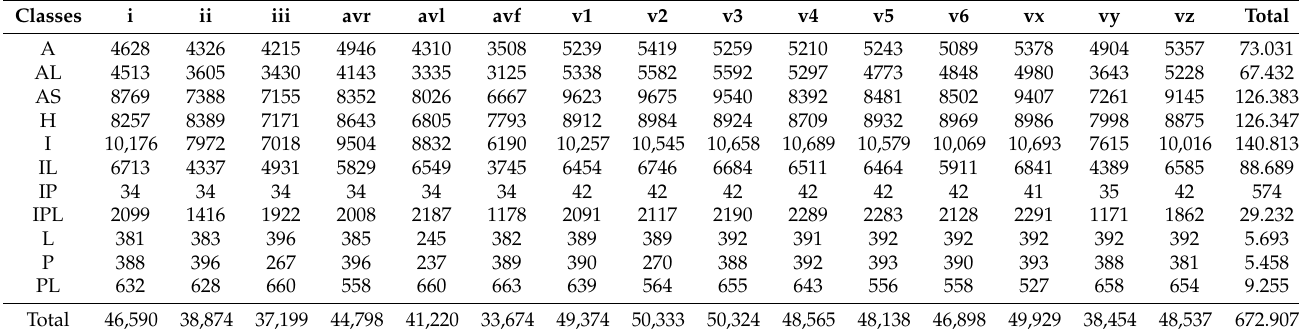
Table 1. The number of beats contained in the 15 lead ECG dataset used.